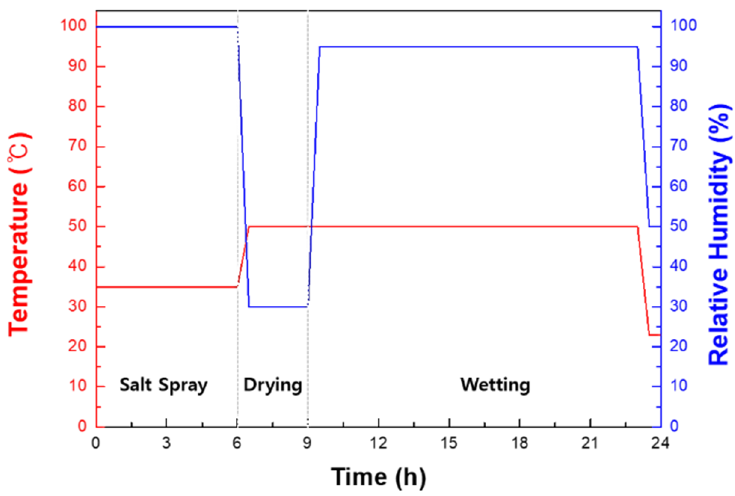
Figure 2. Specific conditions for the cyclic corrosion test.